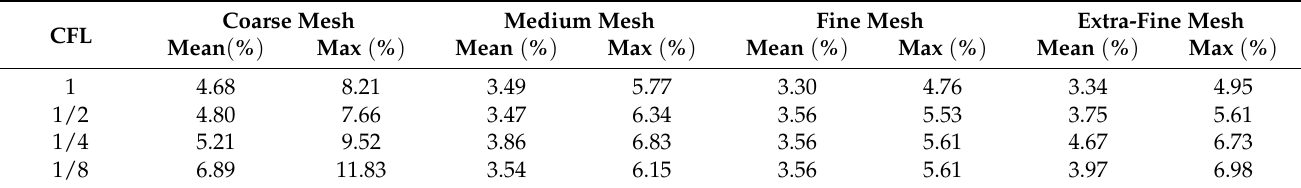
Table 4. Maximum and Mean errors for the Energy-Diffusion